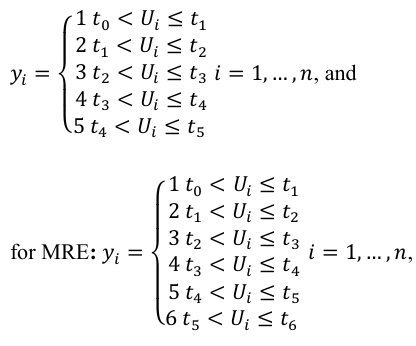
The categories (scores) of the BCS and MRE traits for each i animals are defined by Ui , in the underlying scale, and